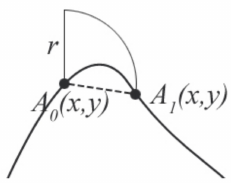
Figure 4. Scheme of searching for segments during vectorization of the steel ladle thermogram.